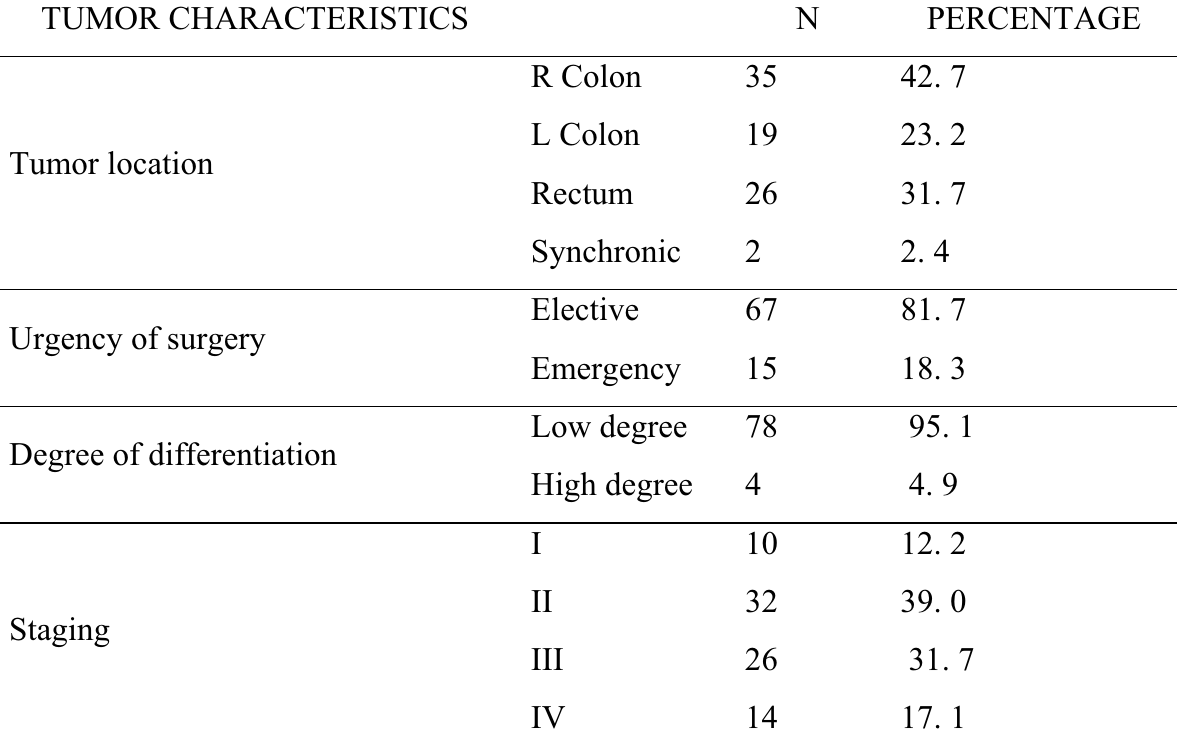
TABLE 1 – Clinical-pathological characteristics of the